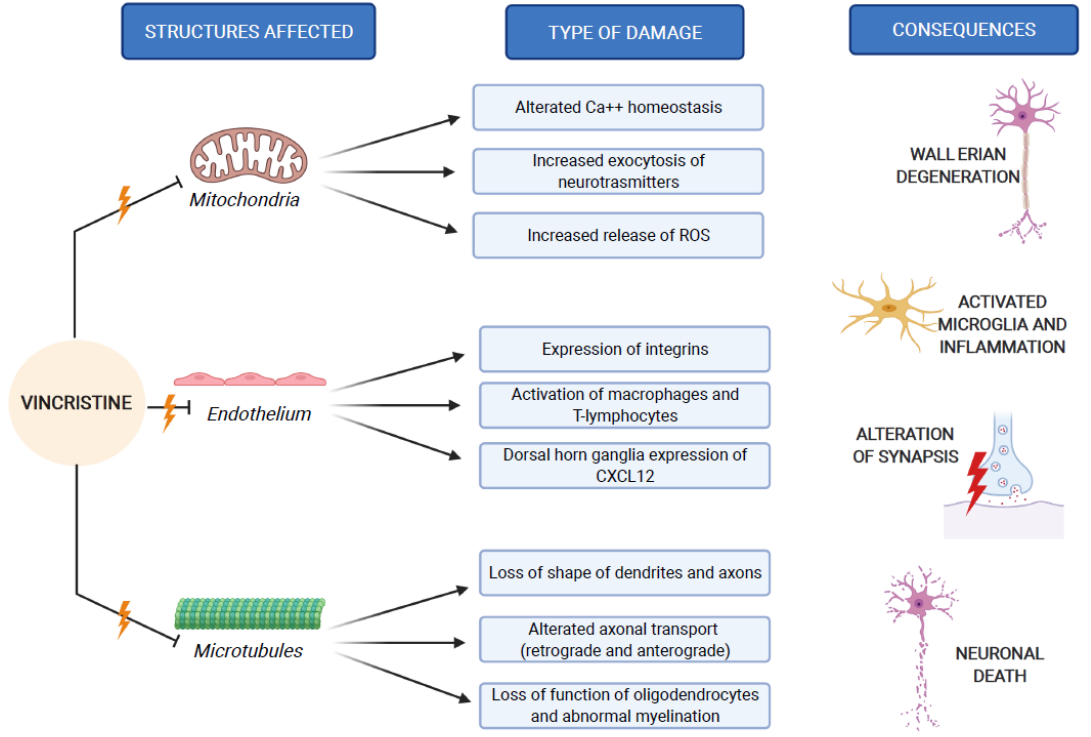
Figure 2. VIPN pathogenesis, which involves mitochondria, endothelium and microtubules of nerve cells.